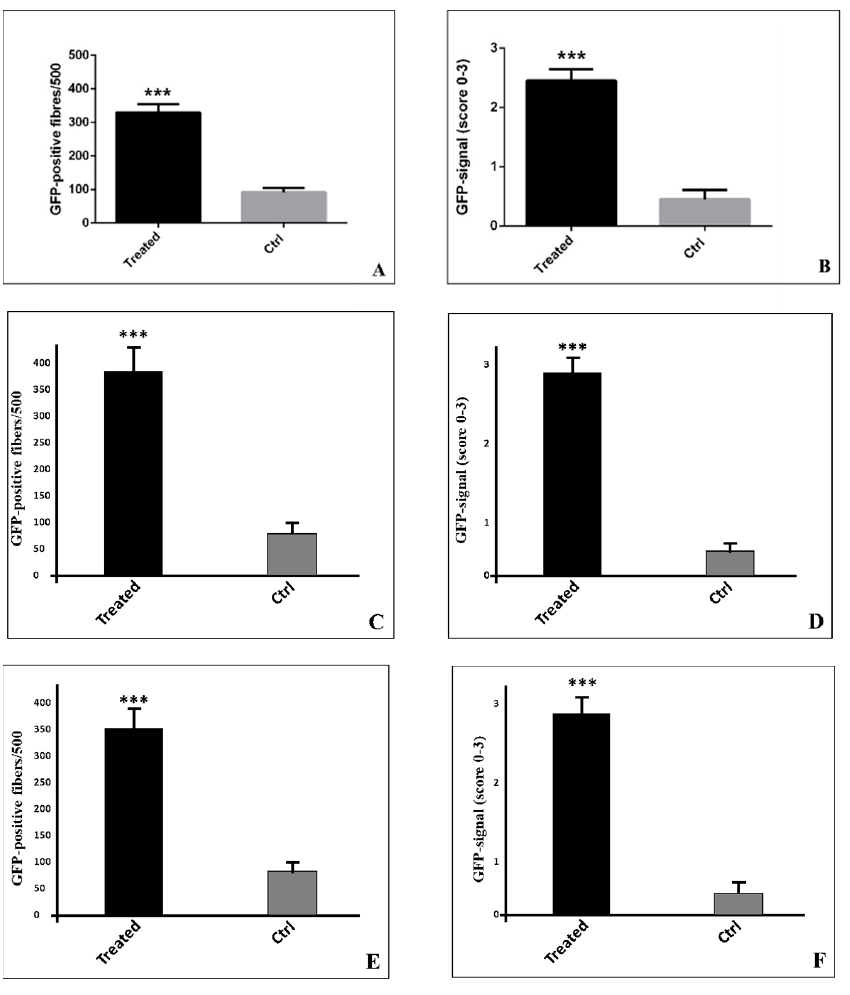
Figure 1. Evaluation of the GFP (Green Fluorescent Protein) signal in skeletal muscle fibers. ( A ) Graph shows the number of GFP-positive muscle fibers in the treated and control groups ( α = 0.05) at day 4. ( B ) Graph displays the GFP signal intensity in the treated and control groups ( α = 0.05) at day 4. ( C ) Graph shows the number of GFP-positive muscle fibers in the treated and control groups ( α = 0.05) at day 10. ( D ) Graph displays the GFP signal intensity in the treated and control groups ( α = 0.05) at day 10. ( E ) Graph shows the number of GFP-positive muscle fibers in the treated and control groups ( α = 0.05) at day 15. ( F ) Graph displays the GFP signal intensity in the treated and control groups ( α = 0.05) at day 15. Asterisks indicate a significant difference between values.